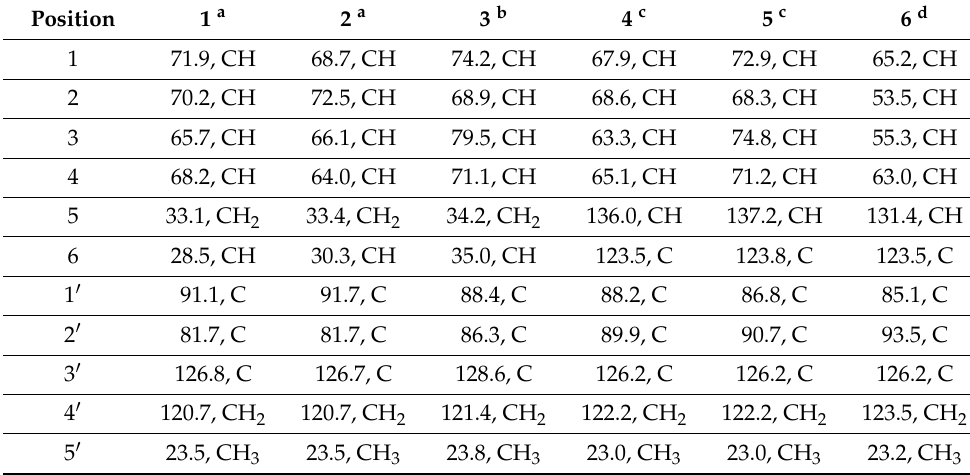
Table 2. 13 C NMR data ( δ in ppm) for compounds 1 – 6